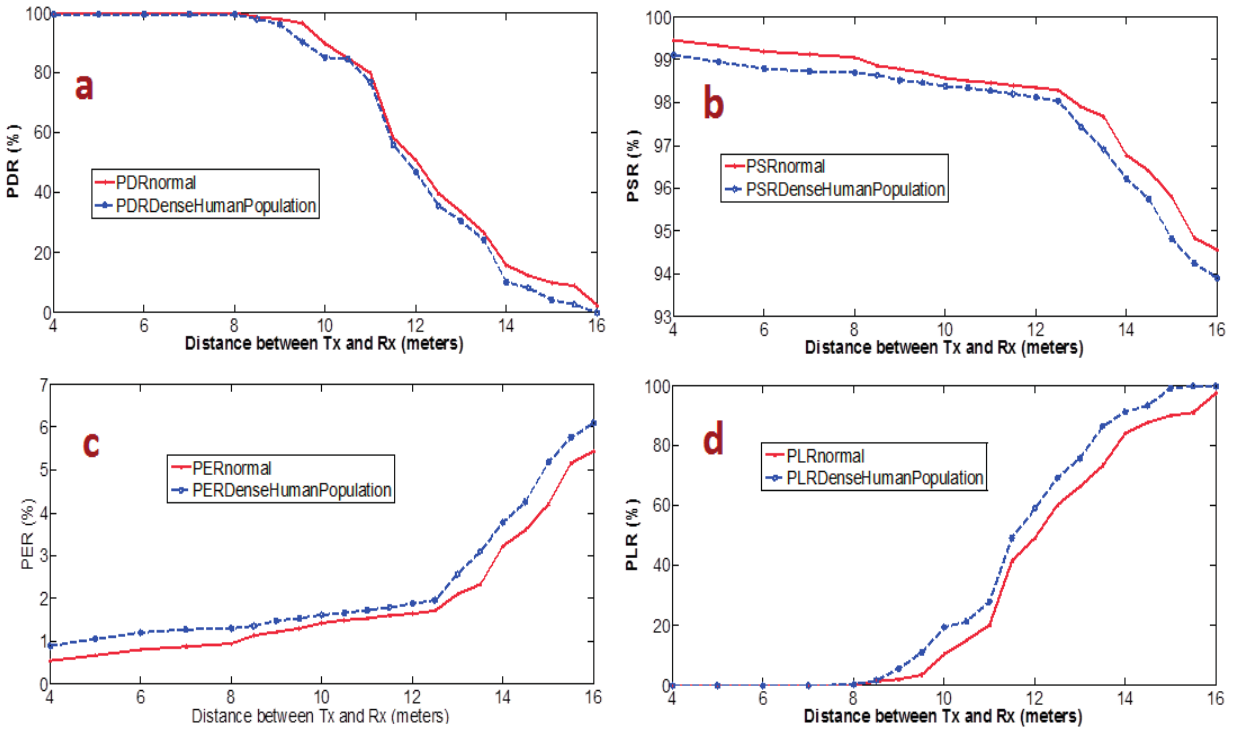
Figure 17. Attenuation loss caused by two different scenarios; one is regular, and other is in a densely populated smart building, measured between transmitter and